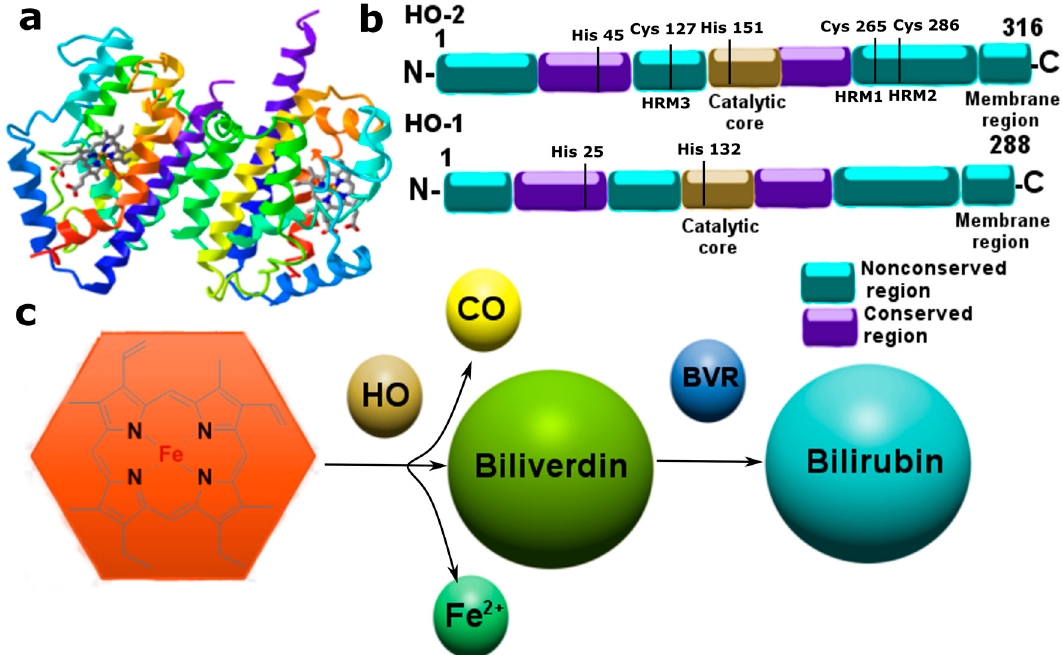
Figure 3. Structural organization of the enzymes responsible for the formation of CO and CO biosynthesis. ( a ) 3D-model of the structural organization of the HO-2 dimer; ( b ) primary structure of HO-1 and HO-2: C-terminal domain required for binding to the cytoplasmic membrane, catalytic domain, and N-terminal cytoplasmic domain. HO-2, unlike HO-1, carries an additional 30 amino acid residues at the N-terminus, as well as two Cys-Pro dipeptides near the C-terminus heme regulatory motifs (HRM); ( c ) schematic pathway of CO biosynthesis: HO catalyzes heme oxidation to form biliverdin CO and Fe 2+ . Biliverdin is converted to bilirubin by the enzyme Biliverdin reductase (BVR).